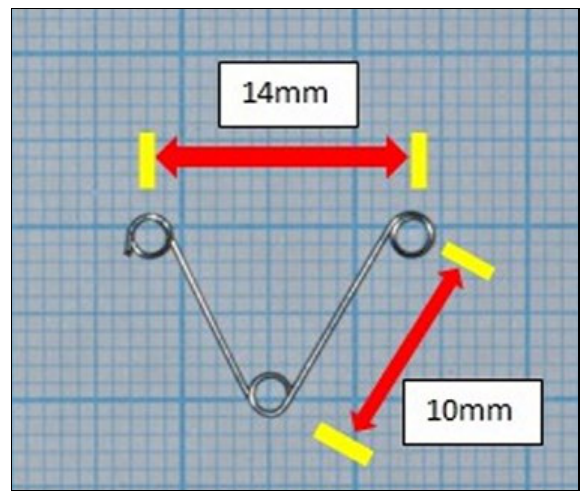
Figure 1. Schematic view of the expansion appliance used.